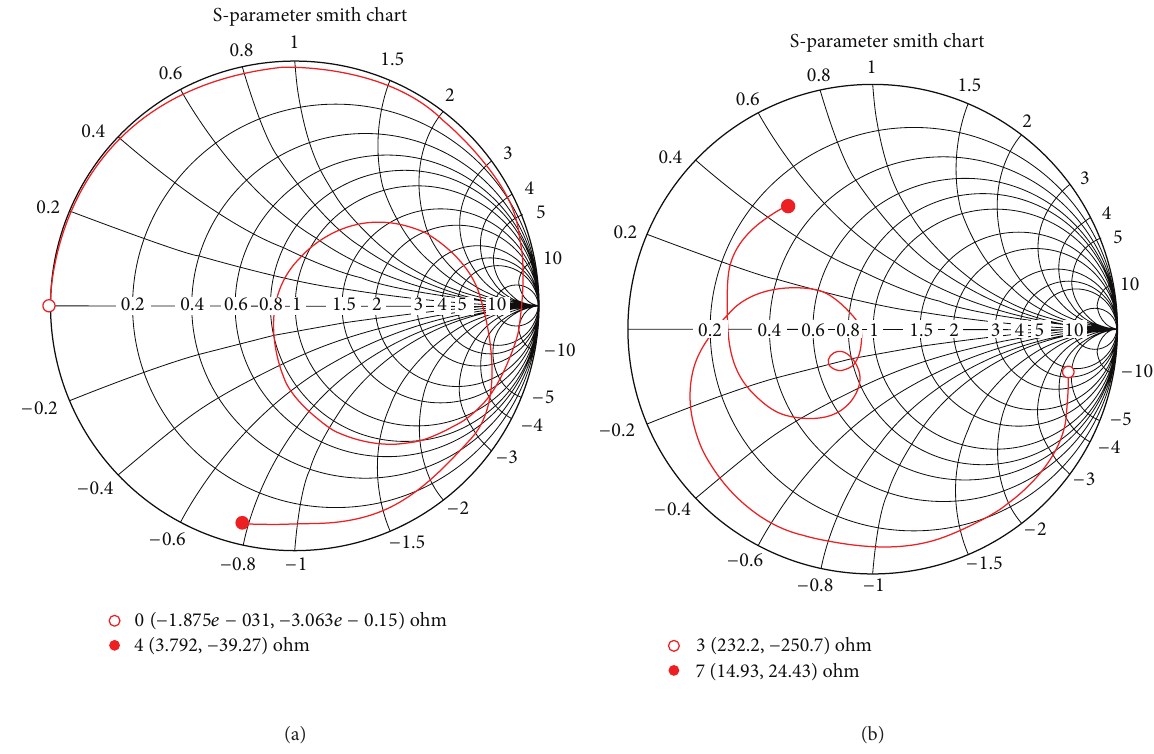
Figure 6: Smith chart of the complex reflection coefficient of the dual-band GK2 PIFA in the overlapping frequency ranges DC-4GHz and 3–7